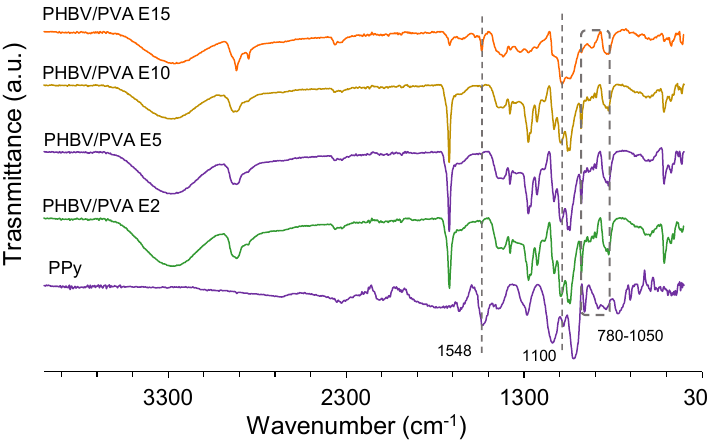
Figure 4. FTIR spectra in the region of 4000–300 cm − 1 . PHBV/PVA E with different percentages of PPy nanoparticles (2%, 5%, 10% and 15% referred to the mass sample).